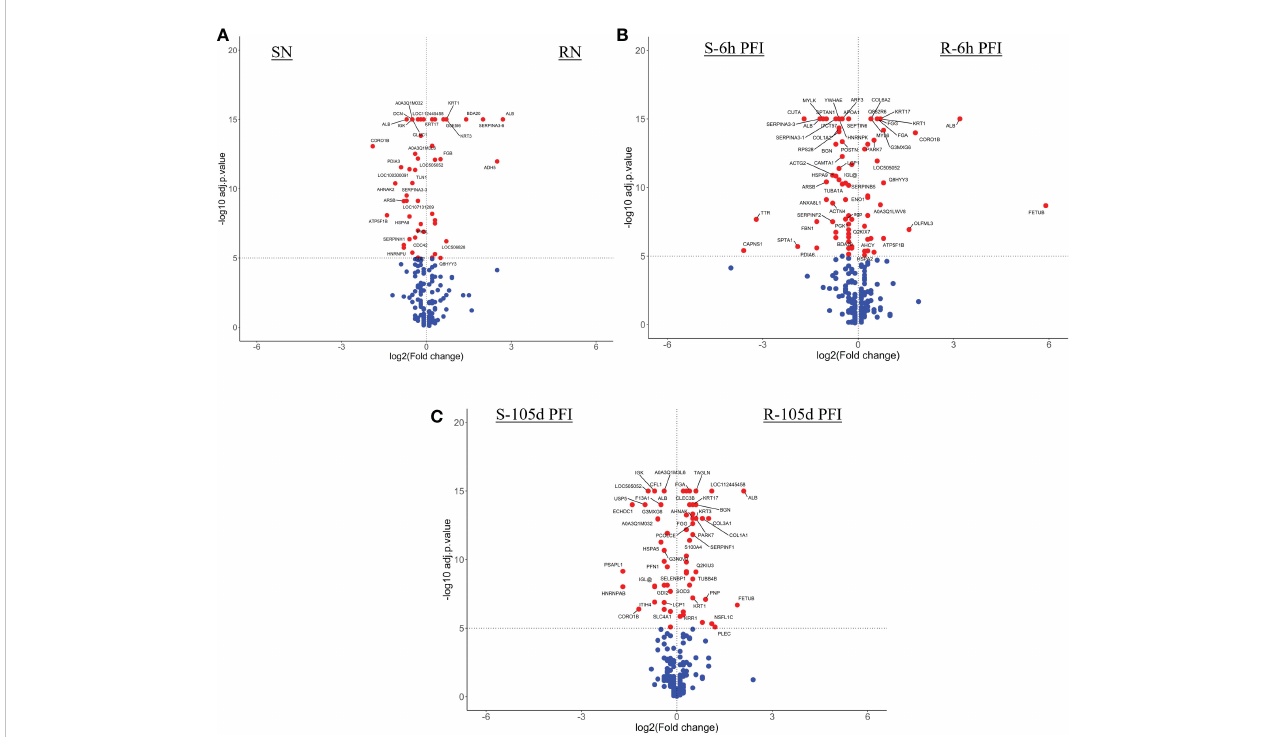
FIGURE 10 Volcano plots illustrating the DA proteins in skin samples of tick-resistant and -susceptible groups of cattle when compared before and after exposure to cattle ticks. DA proteins in (A) susceptible naïve compared to resistant naïve (SN vs RN) samples; susceptible compared to resistant cattle following (B) early (S-6h PFI vs R-6h PFI) and (C) prolonged S-105d PFI vs R-105d PFI tick infestation. Coloured dots represent proteins signi fi cantly different in abundance (P < 10 -5 ). Red, signi fi cantly different in abundance (P < 10 -5 ). Blue, not signi fi cantly different in abundance (P > 10 -5 ).